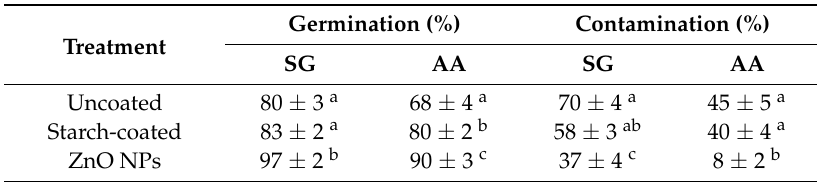
Table 1. Effect of ZnO NPs on the physiological and sanitary quality of maize seeds during standard germination and accelerated aging tests. Germination Treatment